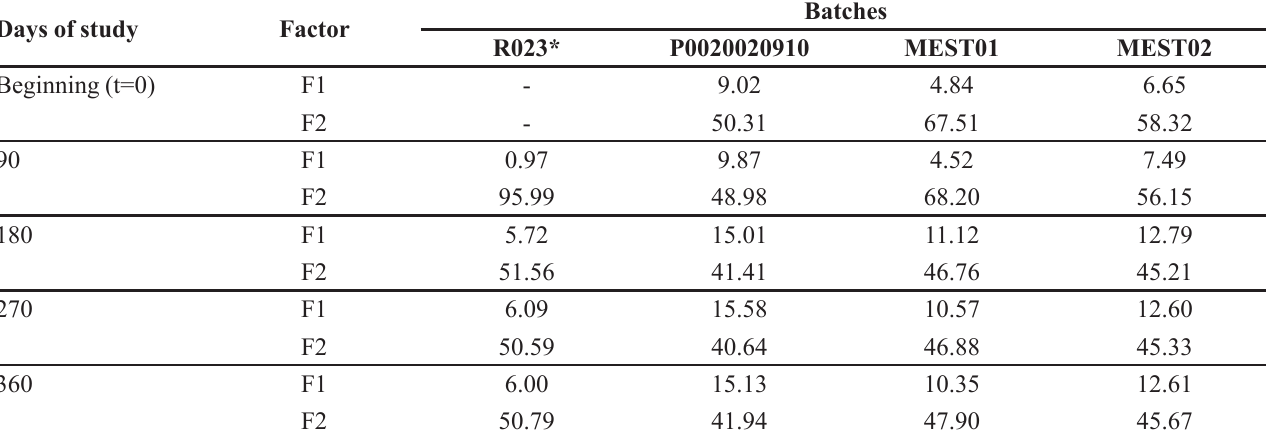
TABLE V - F1 and F2 factors for all of the batches compared with R023 at t=0, t=90, t=180, t=270 and t=360 days of study Days of